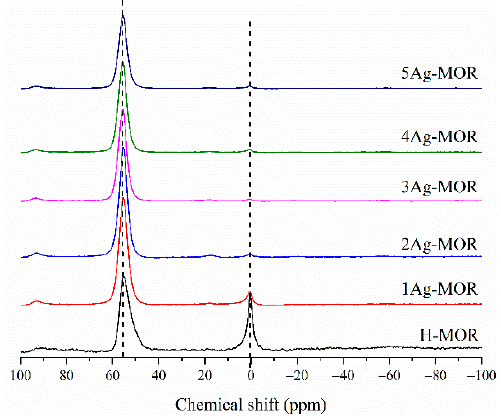
Figure 5. 27 Al MAS NMR spectra of catalysts.